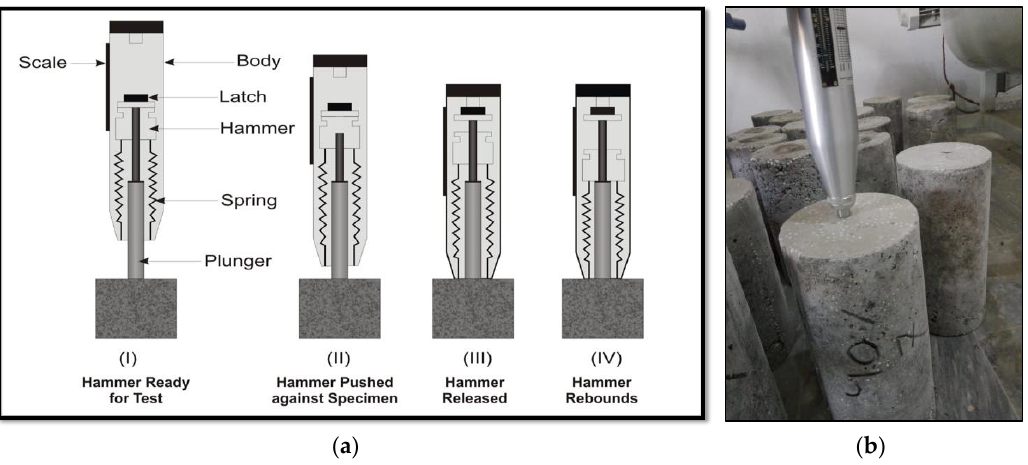
Figure 5. ( a ) Operational diagram of Schmitt Rebound Hammer; ( b ) Sample Testing.